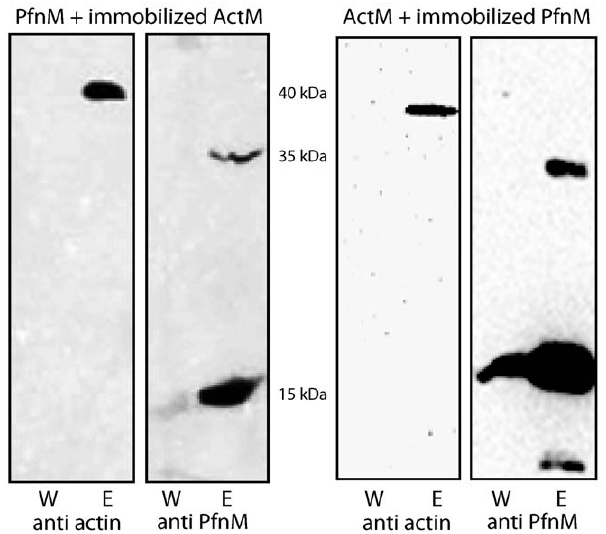
Figure 4. Binding and co-elution of ActM and PfnM. One potential binding partner was immobilized, the other added in solution. Protein blots and immunodetection of final wash (W) and eluate (E) are shown; employed antibody is indicated at the bottom. Molecular weights are 39 kDa for ActM and 17 kDa for PfnM.